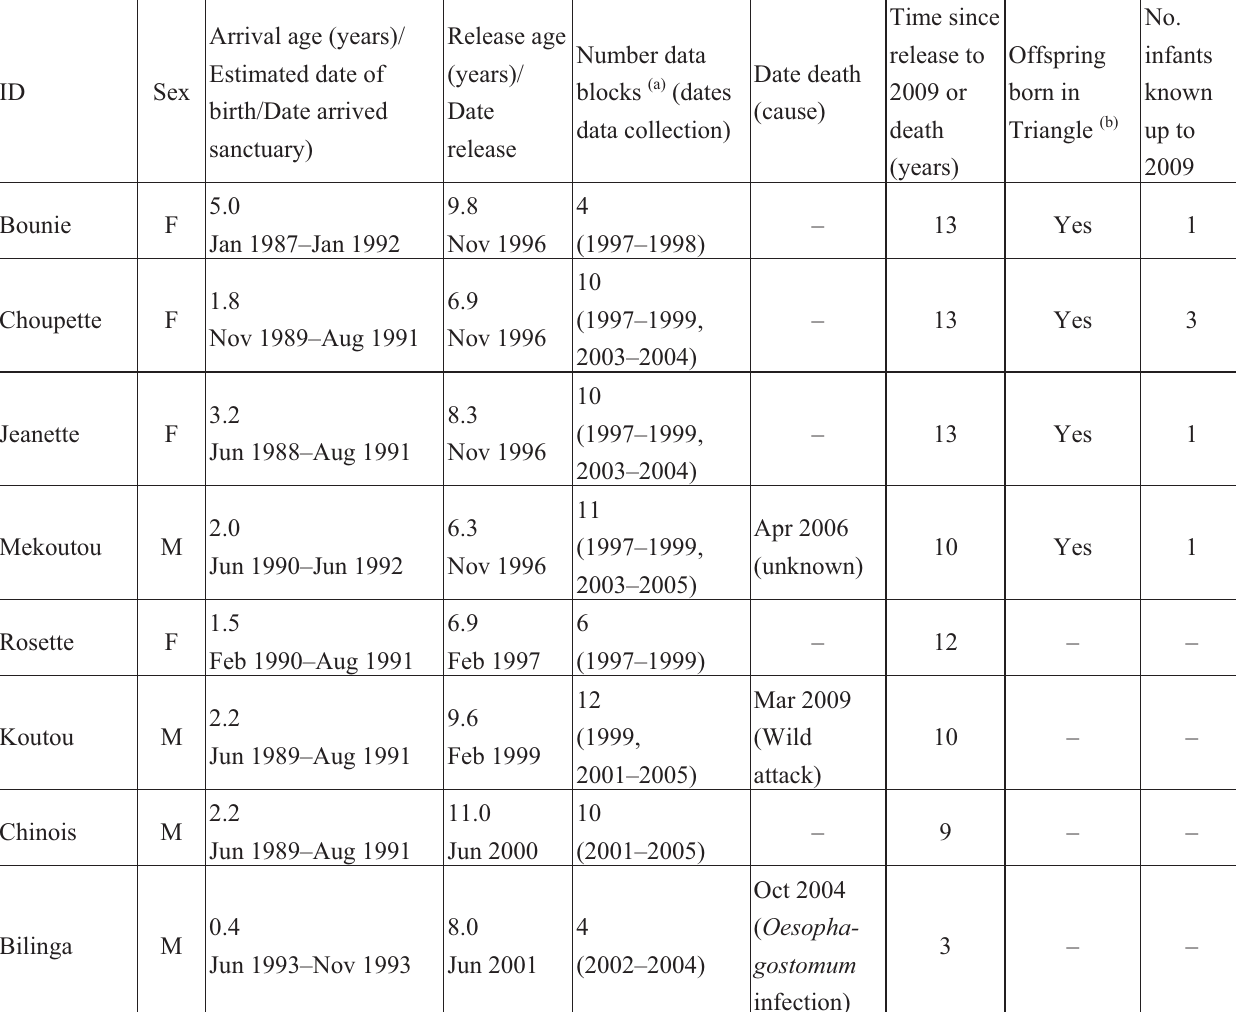
Table 1. Characteristics of released focal